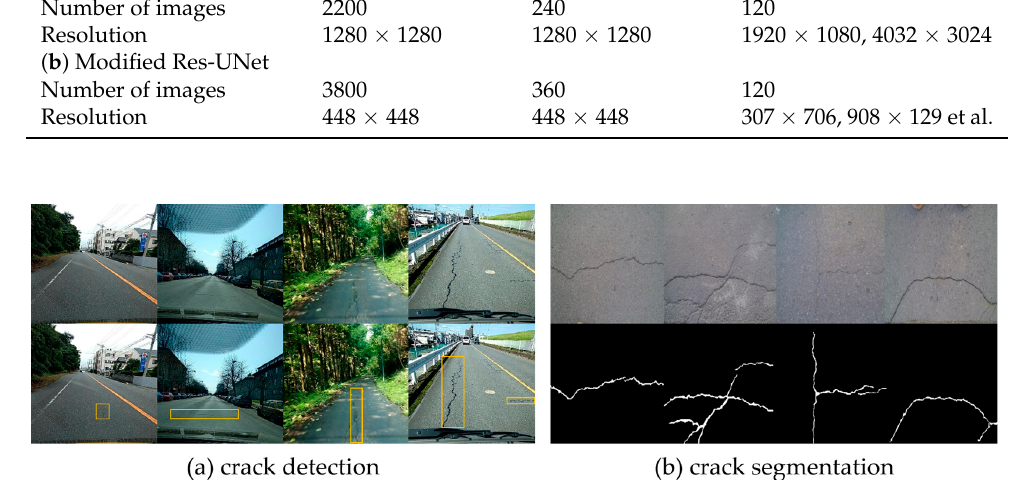
Figure 9. Results of identifying and segmenting cracks based on the publicly available dataset images: ( a ) identifying cracks; and ( b ) segmenting cracks.